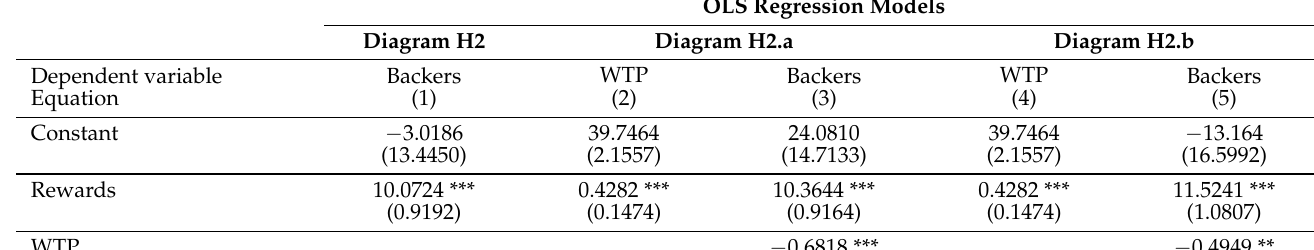
Table 4. Results of the effects of Rewards , WTP and Project Nature on Backers . OLS Regression